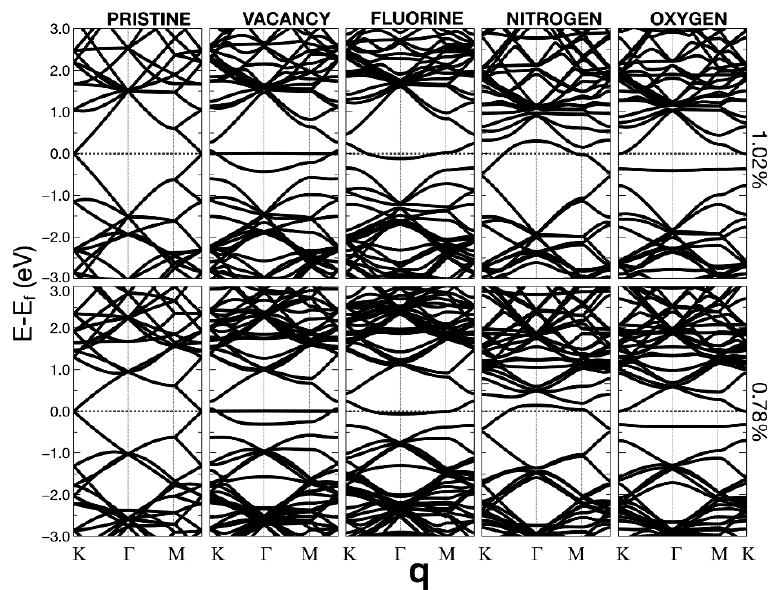
Figure 12. Energy band structures. The left column corresponds to pristine graphene for unit cells of different sizes (containing 2N × N carbon atoms). The 1.02% of dopant (or vacancy) corresponds to a unit cell of 98 bits (N = 7). 1.39% compares to a unit cell with N = 8; The Fermi energy corresponds to the dotted lines. The second column from the left relates to different vacancy percentages. The middle column shows fluorine’s influence as a dopant on the energy band structure when its presence changes several ratios. The other two columns refer to nitrogen and oxygen, respectively.